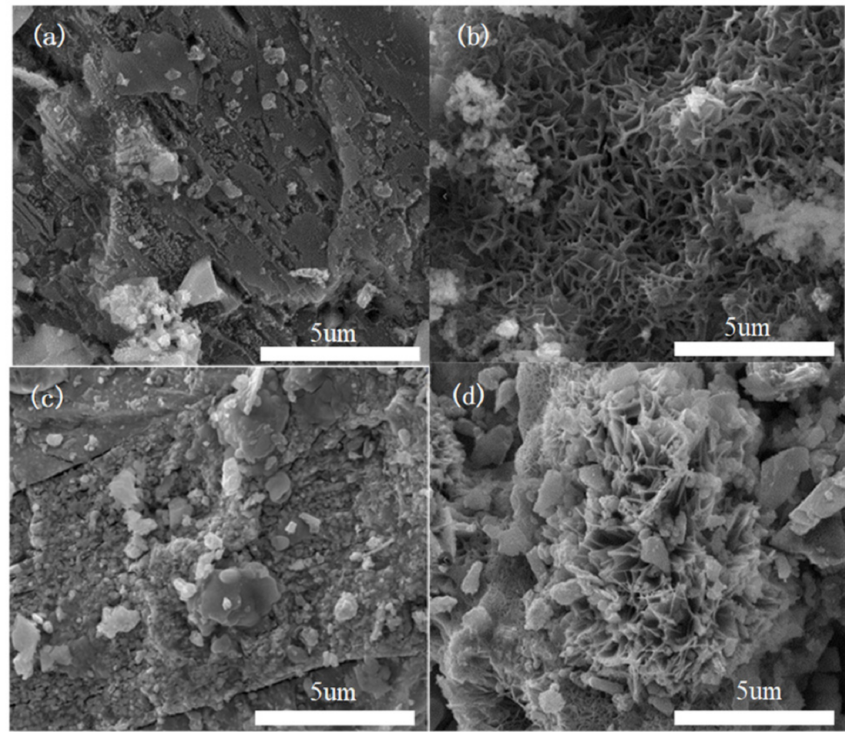
Figure 8. SEM images of Newman ore after reduction: ( a , b ) without coated cow dung, and ( c , d ) with coated cow